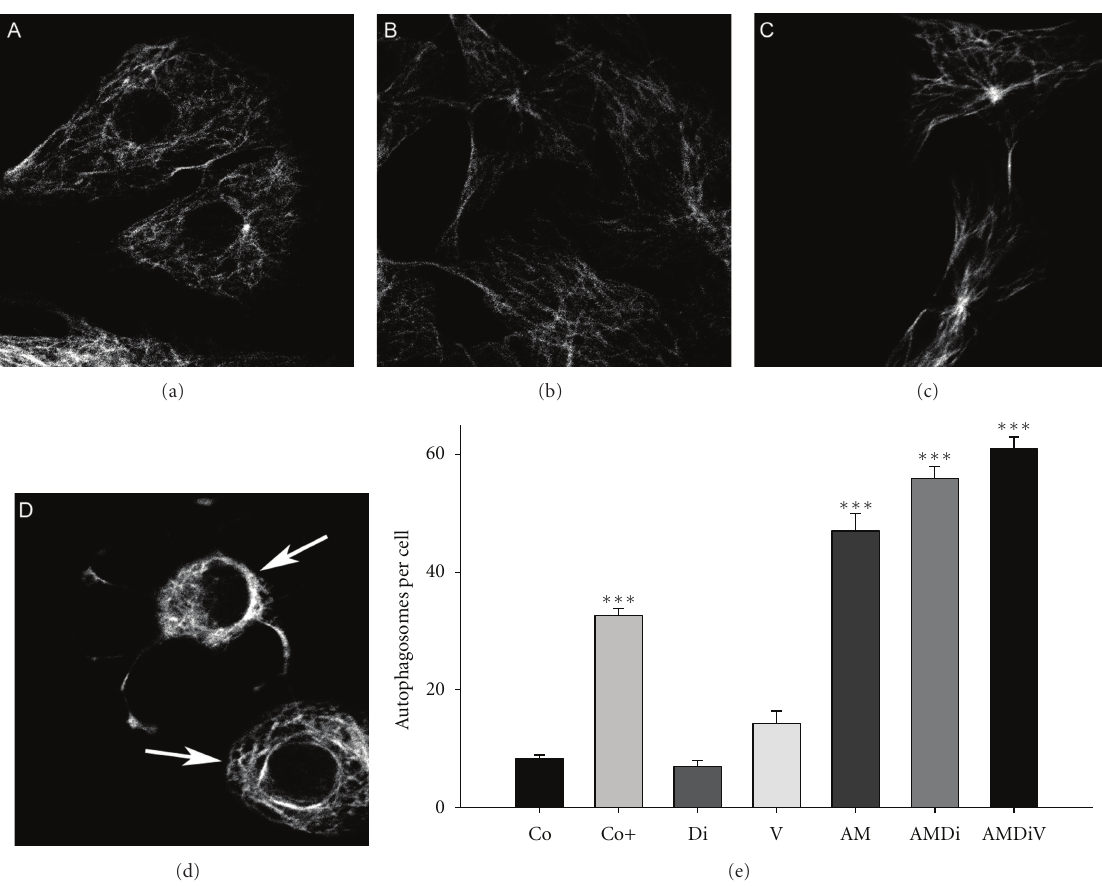
Figure 9: The e ff ects of aminochrome on β -tubulin (a–d) and the accumulation of autophagosomes in the cytosol of cells treated with aminochrome (e). RCSN-3 cells were treated with cell culture medium (a), 100 μ M dicoumarol (b), 50 μ M aminochrome (c), and 50 μ M aminochrome and 100 μ M dicoumarol (d) and incubated for 48 h as described by Paris et al. 2010 [15]. In (e) the number of autophagosomes per cell was determined by incubating RCSN3 cells for 24 h with cell culture medium (Co), 100 μ M dicoumarol (Di), 10 μ M vinblastine (V), 20 μ M aminochrome (AM), 20 μ M aminochrome and 100 μ M dicoumarol (AMDi), 20 μ M aminochrome and 100 μ M dicoumarol and 10 μ M vinblastine (AMDiV). As a positive control, cells were incubated with cell culture medium without bovine serum (Co+). The statistical significance was assessed using ANOVA for multiple comparisons and Student’s t test ( ∗∗∗ P < 0 . 001). This experiment was performed as described by Paris et al. 2011